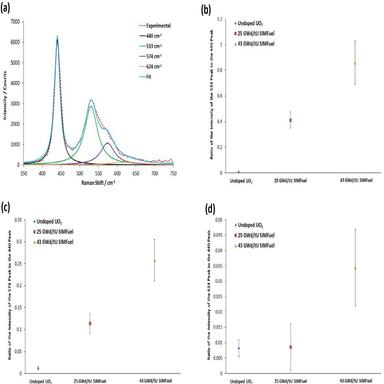
(a) Example Lorentzian peak fit of a single spectra from the 25 GWd/tU SIMFuel sample. (b) Ratio of the 533 peak to the 440 T2g for undoped UO2, 25 GWd/tU SIMFuel and 43 GWd/tU. (c) Ratio of the 574 peak to the 440 T2g for undoped UO2, 25 GWd/tU SIMFuel and 43 GWd/tU. (d) Ratio of the 624 peak to the 440 T2g for undoped UO2, 25 GWd/tU SIMFuel and 43 GWd/tU.